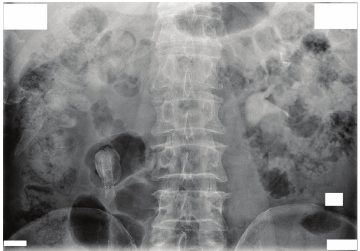
Figure 1: Intravenous urography shows a 35 mm stone encrusted on a nitinol mesh stent positioned in the right ureteropelvic (UP) junction, with delayed contrast medium excretion in the right kidney.